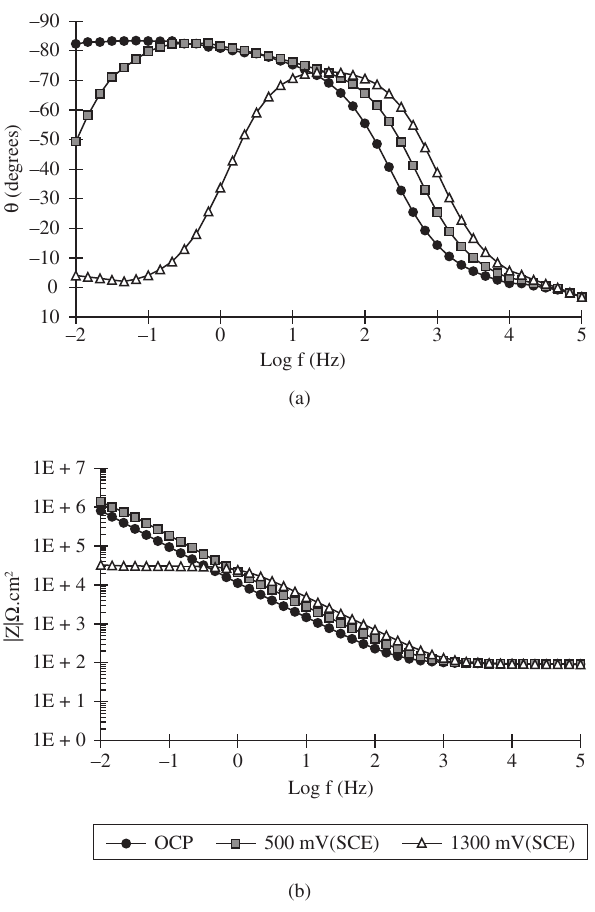
Figure 2. Bode diagrams for Ti-13Nb-13Zr alloy after 72 hours of immer- sion in Hanks’ solution obtained at OCP, 500 mV(SCE) and 1300 mV(SCE): a) Phase angle Bode diagram; and b) Z modulus Bode